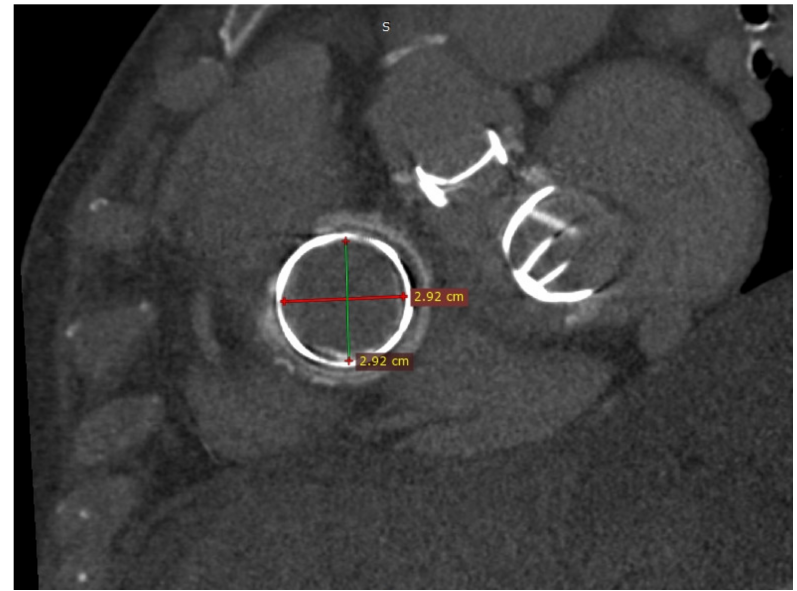
Figure 2. Cardiac computed tomography angiography measurements of the pre-existing tricuspid